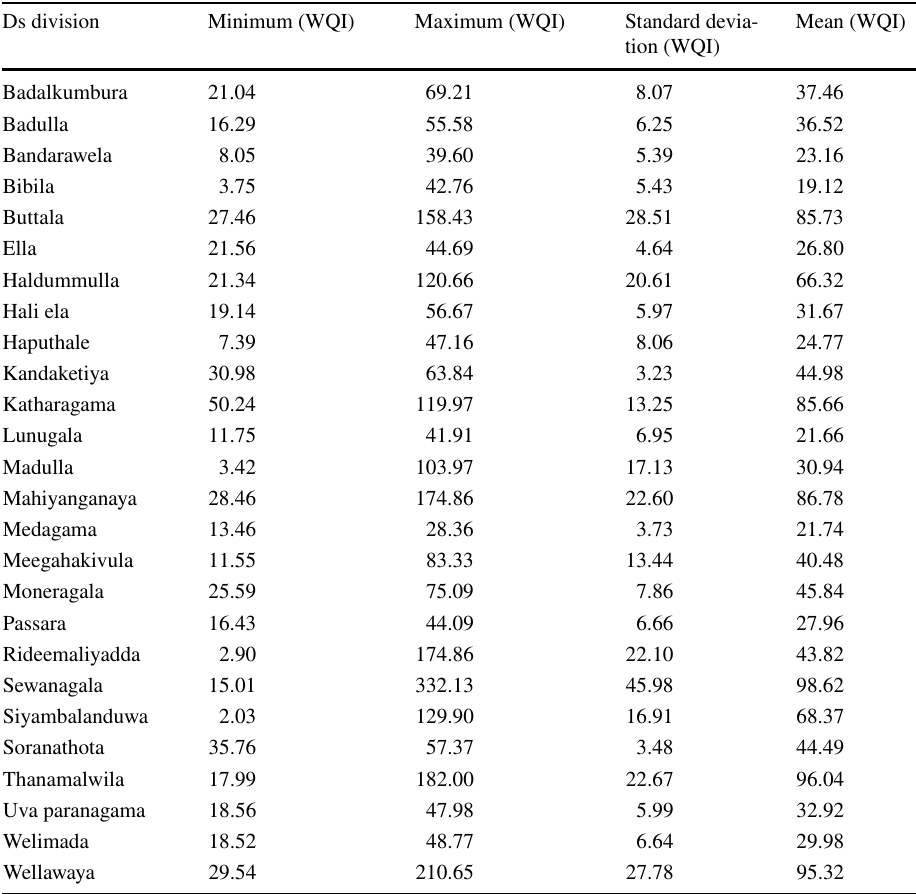
Table 6 Statistical data of WQI in each DS